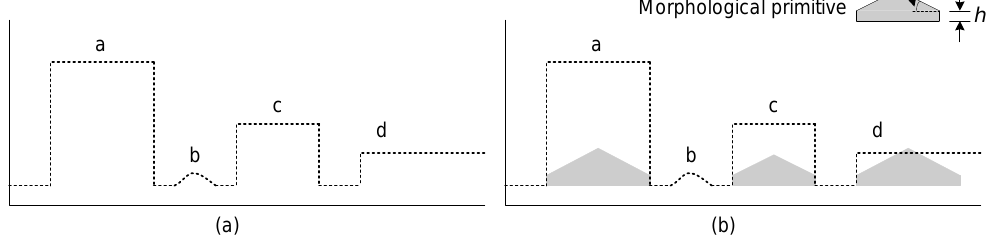
Figure 3. Example of the morphological primitive for filtering: ( a ) input set f ; and ( b ) the morphological primitive self-adaptively fitting different objects.